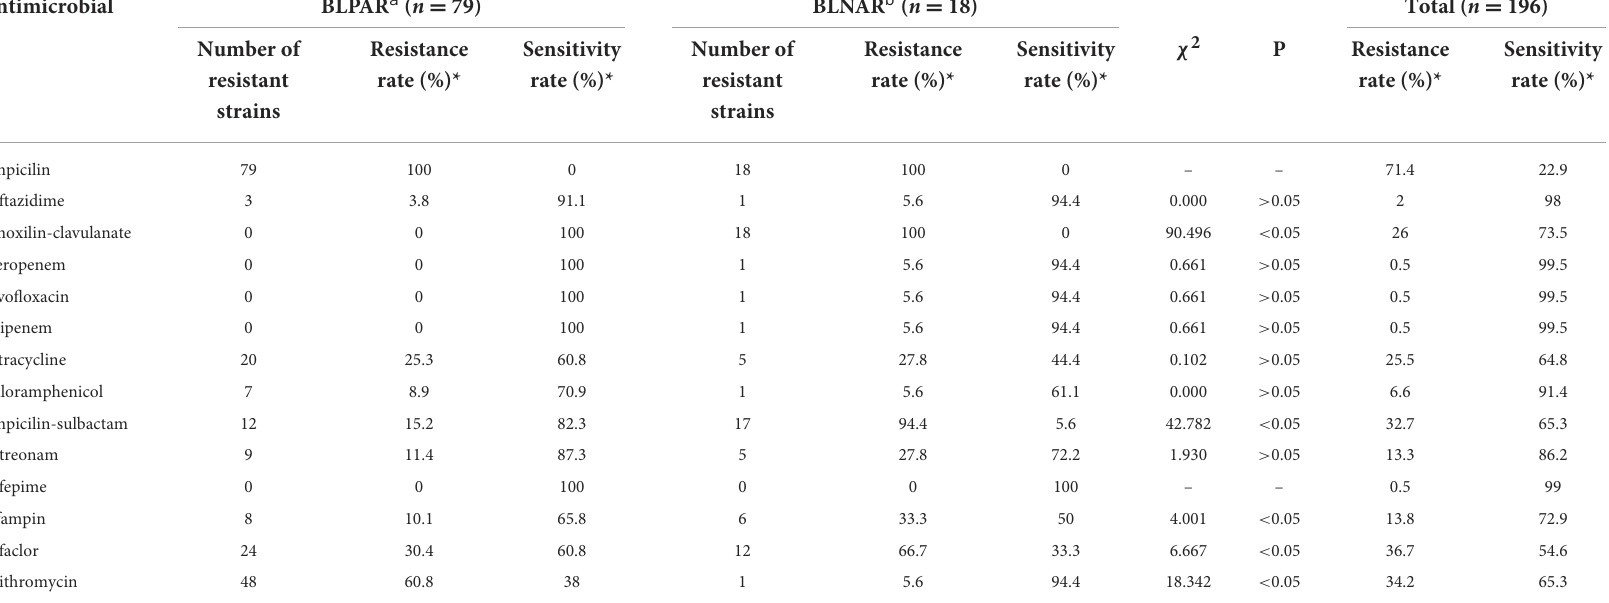
TABLE 1 Drug resistance rate and susceptibility rate of BLPAR and BLNAR strains to antibiotics. Antimicrobial BLPAR a ( n = 79) BLNAR b ( n = 18) Total ( n = 196) Number of Resistance Sensitivity Number of resistant rate (%)* rate (%)* resistant strains strains